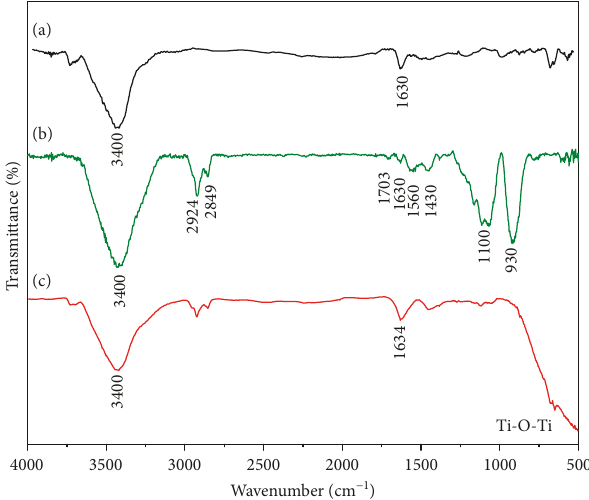
Figure 4: FTIR spectra of (a) pristine, (b) oxidized (functional- ized), and (c) TiO 2 -coated MWCNTs with I coating cycle after calcination at 1000 °